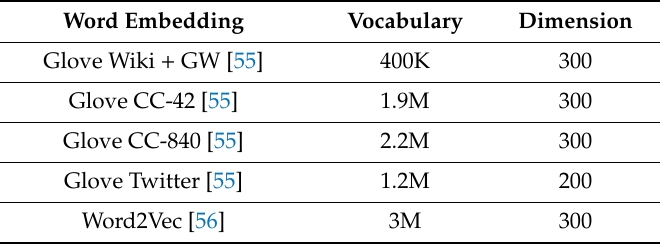
Table A1. Non-biomedical word embedding.